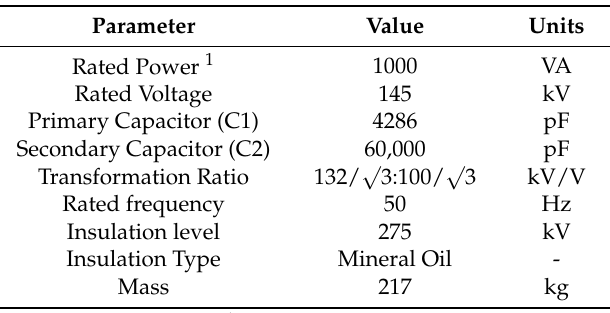
Figure 6. Details of the SFRA measurement campaign to experimentally characterize a CVT: ( a ), Picture of the CVT under test inside a secure substation bay ( b ), Doble M5100 SFRA instrument ( c ), CVT functional diagram, ( d ) test connections realized for the CVT frequency analysis. Table 1. Nameplate data of the CVT under test.